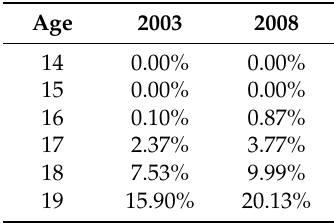
Data: Survey Assessment of Vietnamese Youth 2003 and